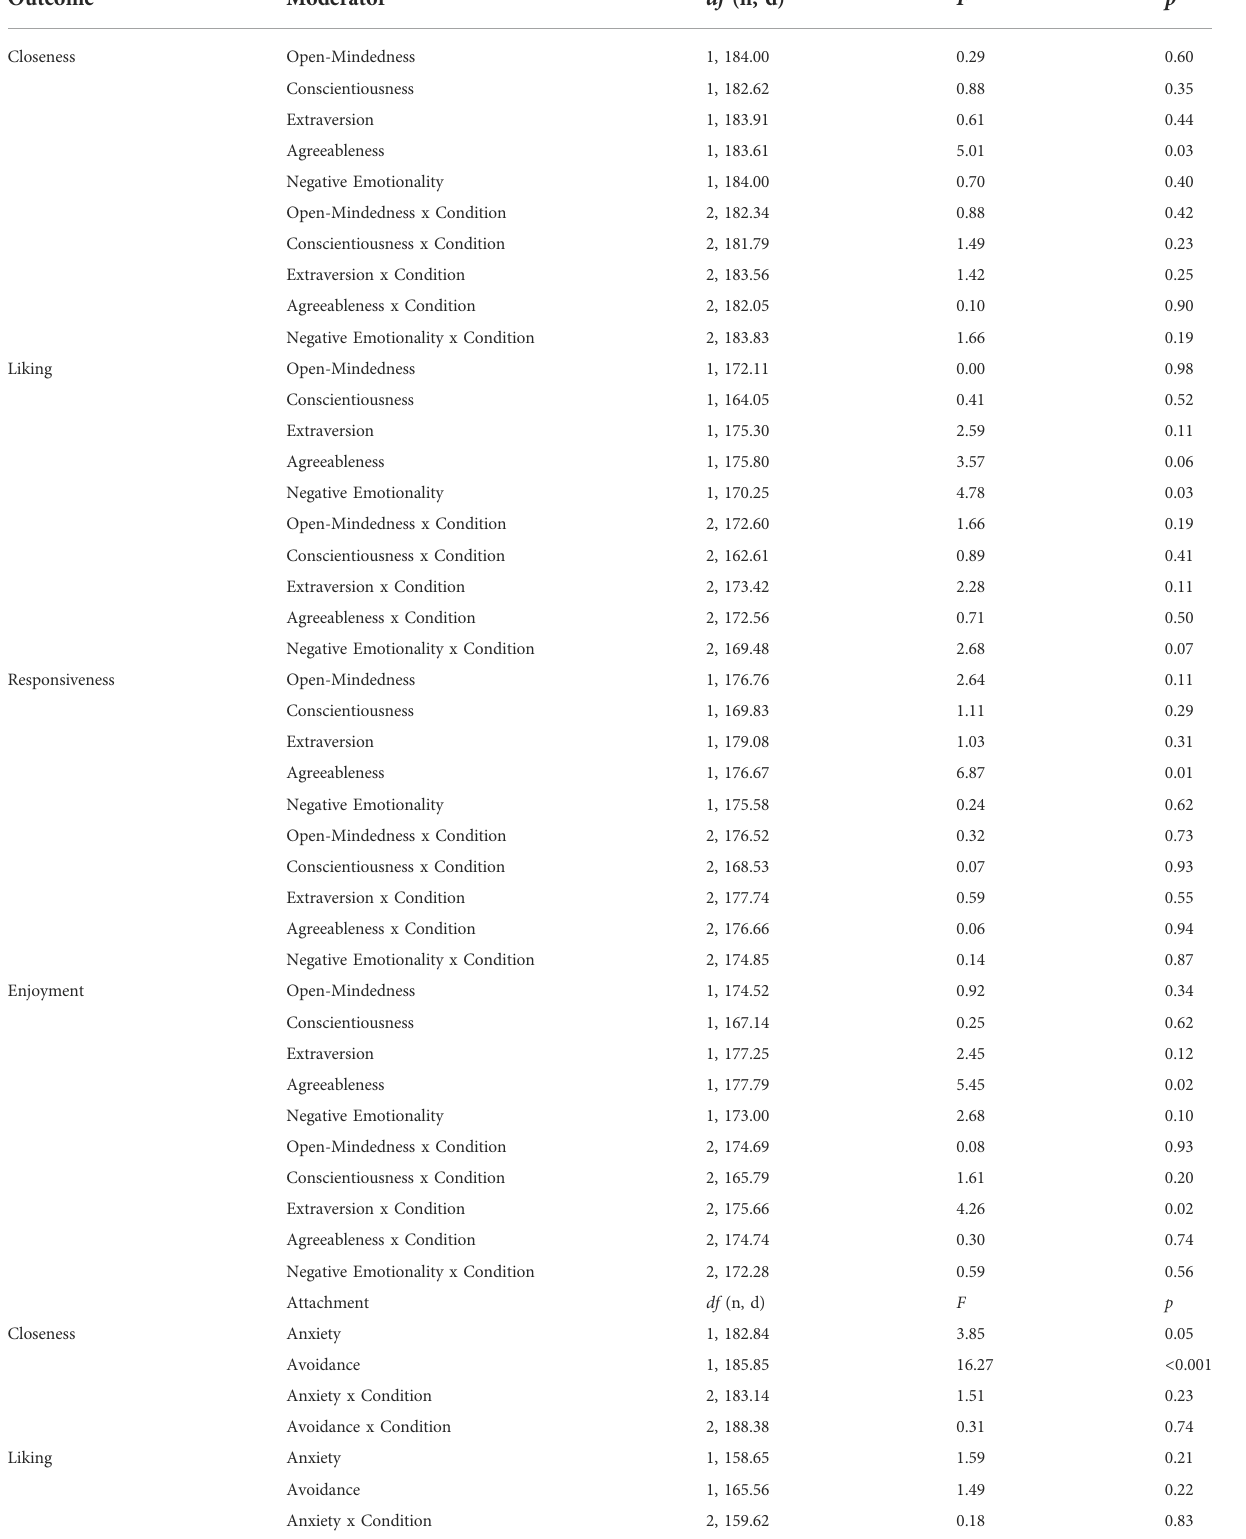
TABLE 3 Moderator Analyses of Avatar Condition Effects: Personality and Attachment Outcome